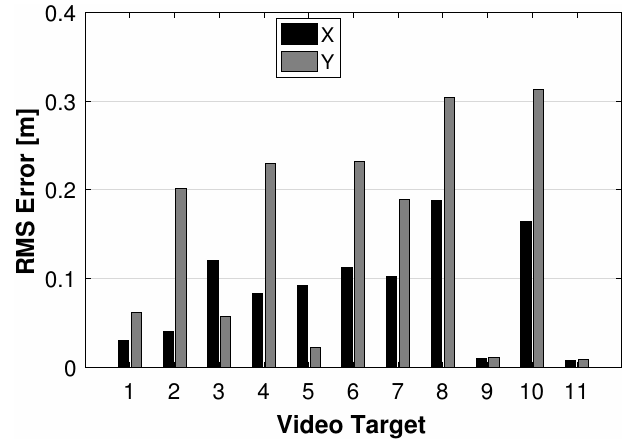
Figure 13. RMSE of the centroid estimate using the multi-spectral video tracker for the ground-truthed video